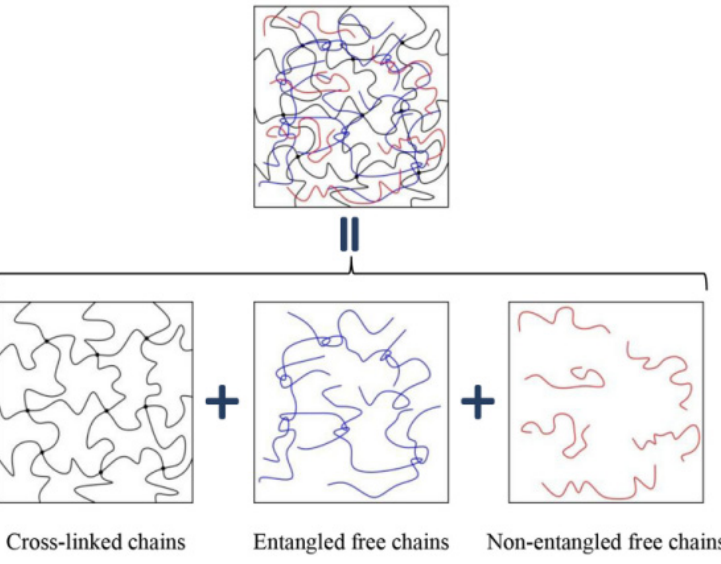
Figure 13. Rubber network is decomposed into three superposed chain populations [21].